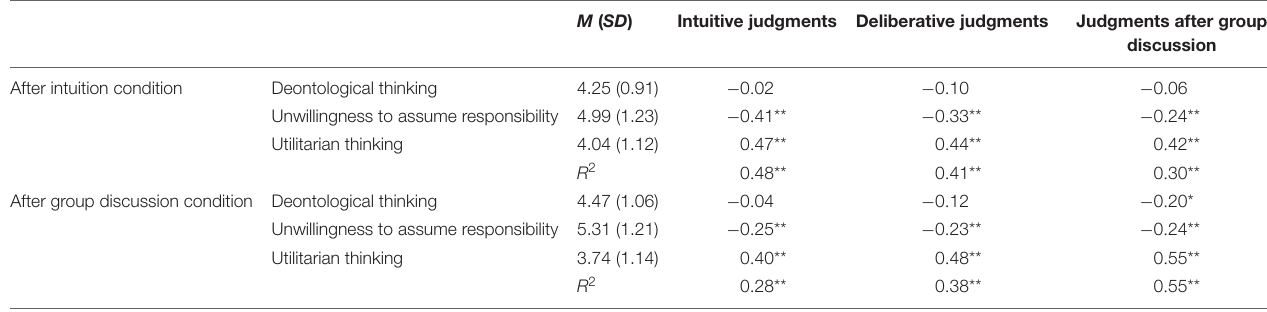
TABLE 2 | Regression analyses to predict intuitive judgments, deliberative judgments, and the judgments after group discussion by the thinking scale regarding the moral dilemma. M ( SD ) Intuitive judgments Deliberative judgments Judgments after group